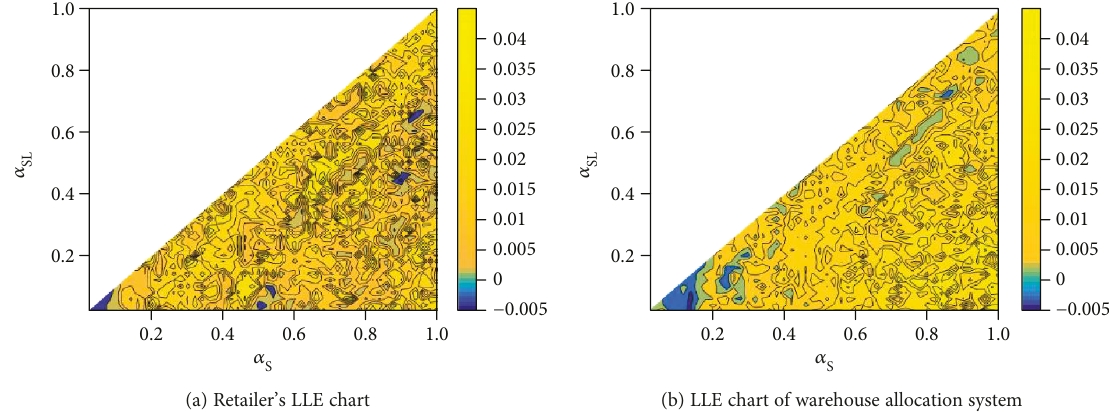
Figure 6: LLE diagram of members under the scenario of random demand obeying uniform distribution.